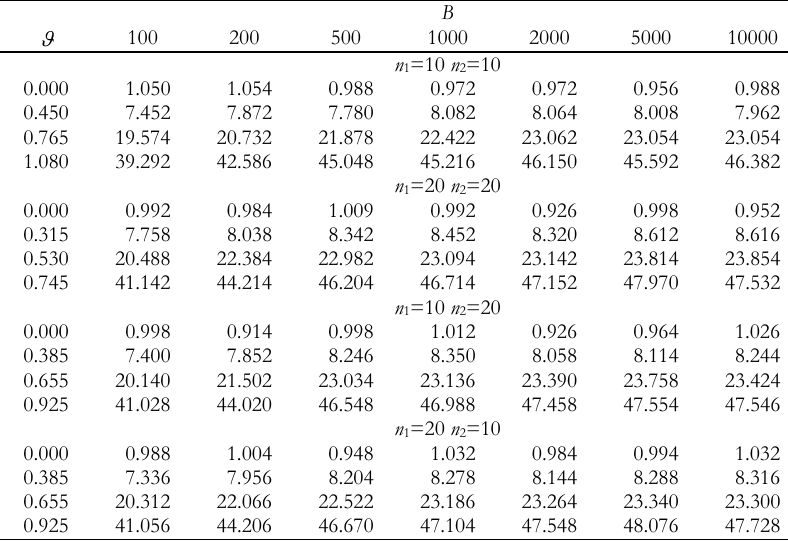
Percent power estimates of T for (cid:68) =